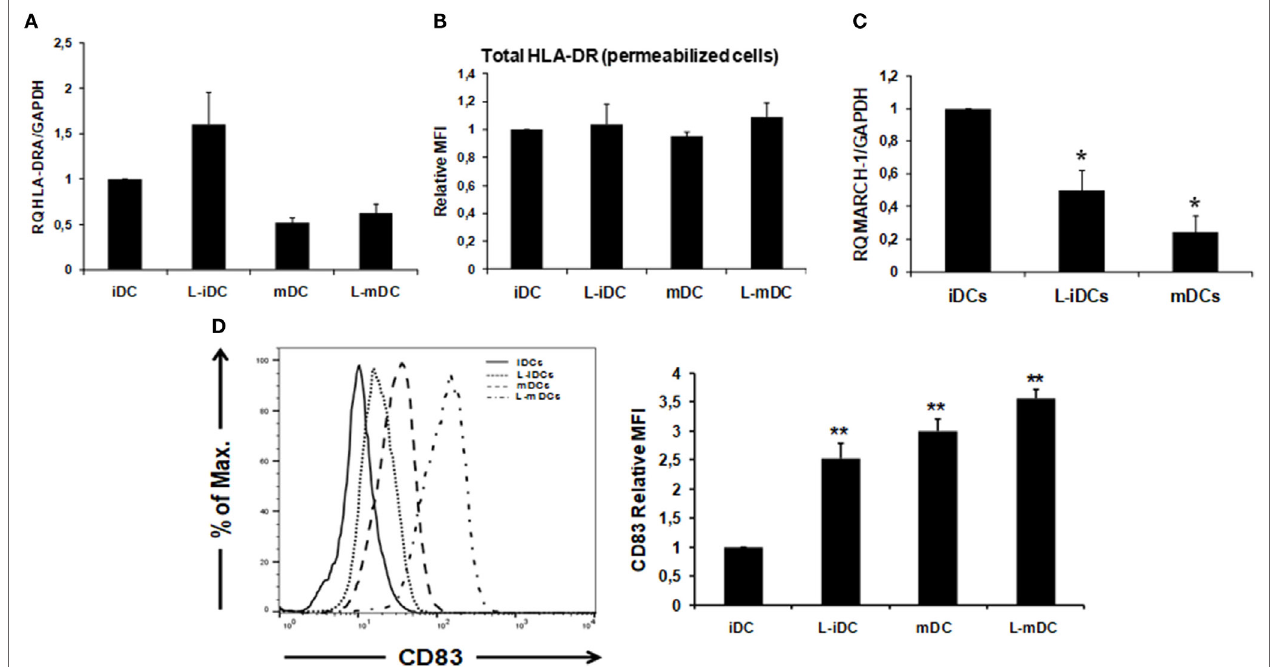
FigUre 3 | HLA-DR cell surface expression correlates with an increase in CD83 expression and a downregulation of MARCH-1. (a) Relative quantification of HLA-DRA gene transcription in control and L-DCs. Data (mean ± SDs) from three independent experiments are shown. (B) Total HLA-DR protein (extra + intracellular) levels were assessed by flow cytometry in lenalidomide-treated and untreated DCs. Data from three independent experiments are shown as the relative mean of fluorescence intensity (MFI) ± SDs from permeabilized cells (* p < 0.05; ** p < 0.03). (c) MARCH-1 mRNA is downregulated in L-DCs. Q-PCR data from four independent experiments are shown as mean gene expression levels relative to the expression of GAPDH (* p < 0.05; ** p < 0.03). (D) CD83 surface expression is upregulated in DCs differentiated in the presence of lenalidomide, as measured by flow cytometry. Left: the histogram shows a representative experiment. Right: relative MFI ± SDs from six independent